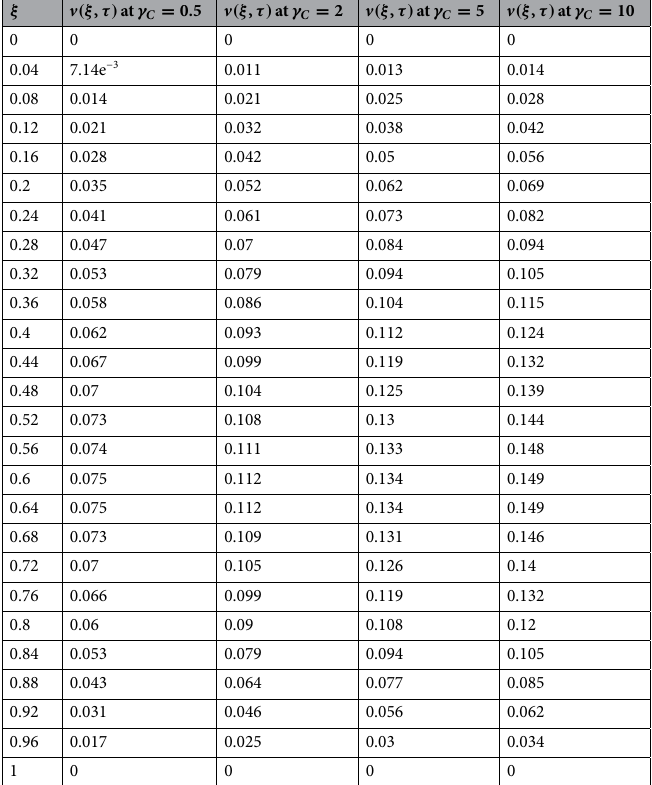
Table 3. Variations in velocity profile against ξ if h (τ) = 1 for different values of γ C .